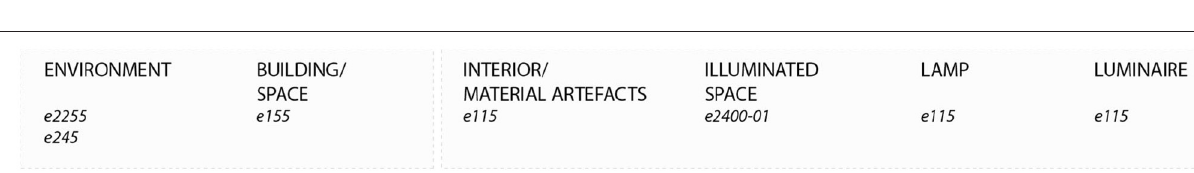
FIGURE 1 | The ICF disability model [(1), p. 9] adapted for low vision rehabilitation, including the classification’s further subdivision of environmental factors.